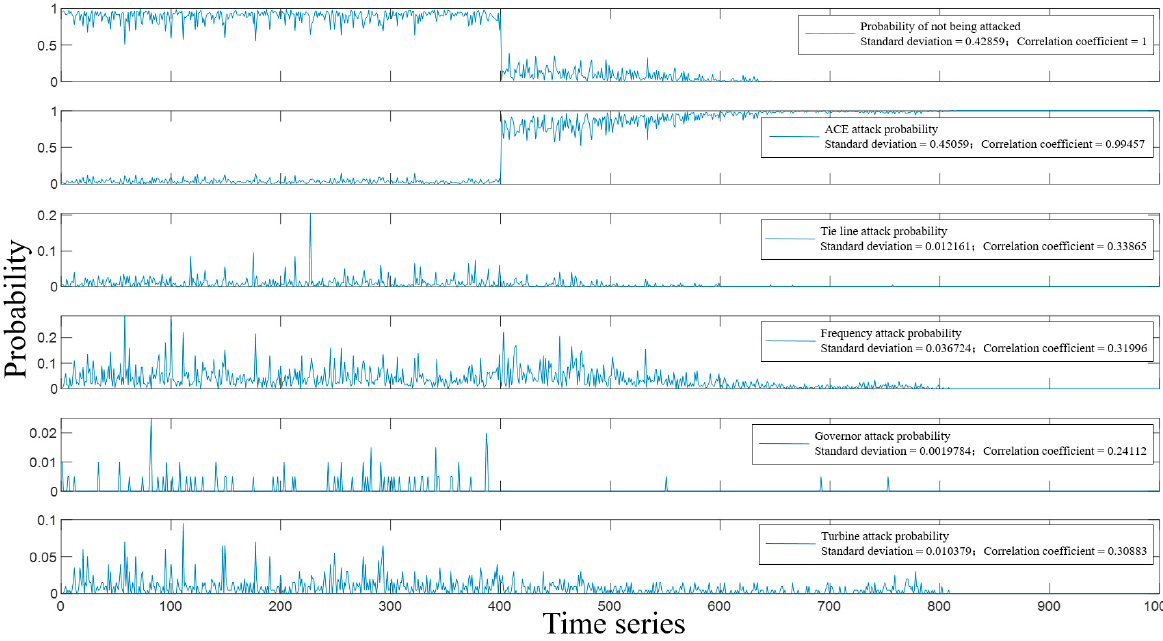
Figure 6. ACE Single-State Variable Attack Probability Detection Value.